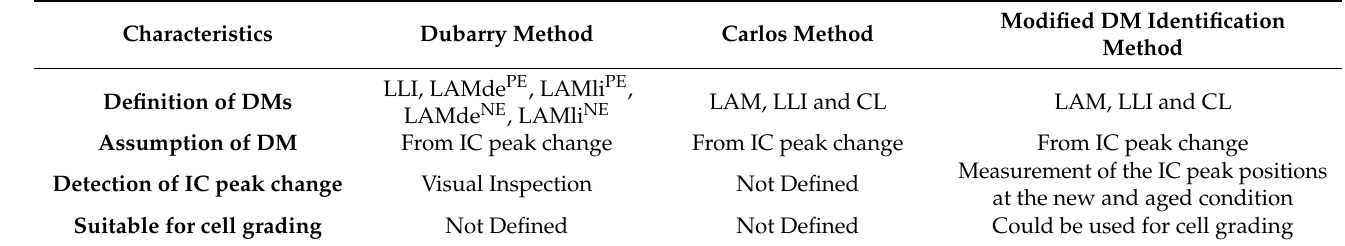
Table 3. Comparison of modified DM identification technique with other